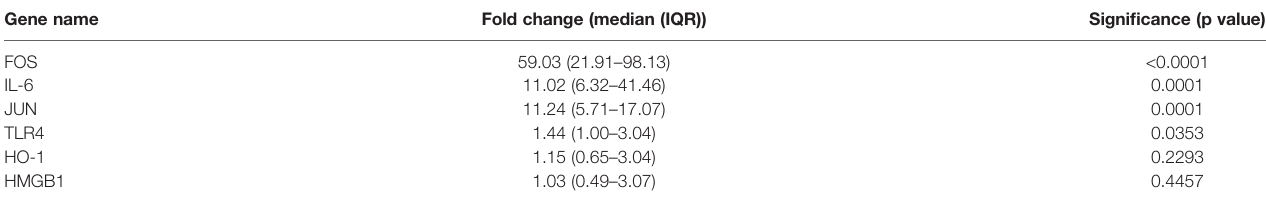
TABLE 3 | Expression of genes in tissue measured using